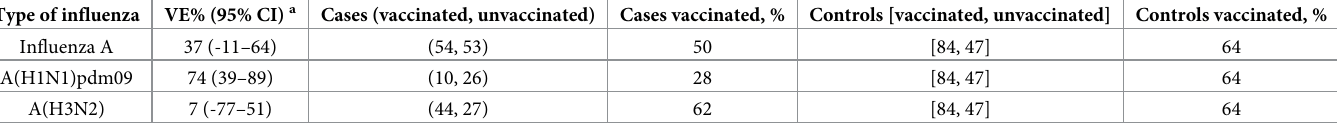
Table 3. Adjusted vaccine effectiveness (VE) of quadrivalent inactivated influenza vaccine for preventing influenza in the 2018/19 season (n = 4243). Adjusted vac- cine effectiveness (VE) of quadrivalent inactivated influenza vaccine for preventing influenza A(H1N1)pdm09 and A(H3N2) in 3 hospitals that used rapid influenza diag- nostic test kits for detecting A(H1N1)pdm09 (N =